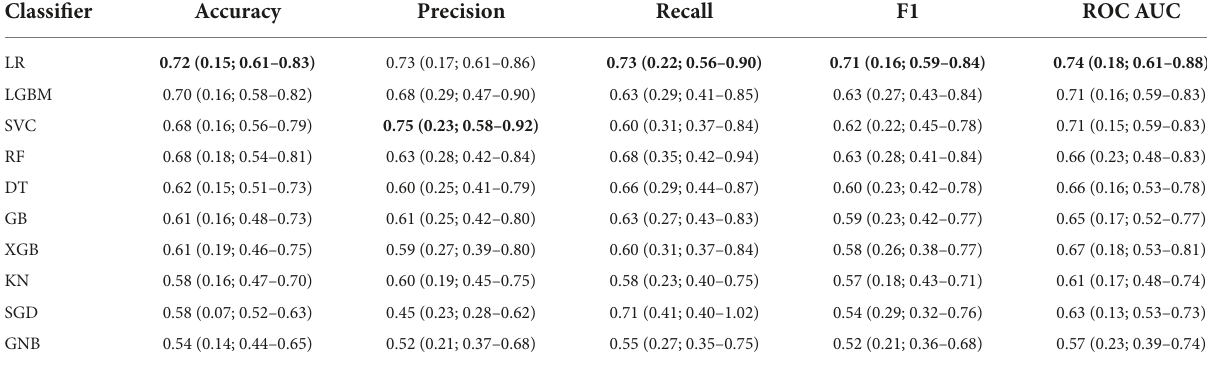
TABLE 5 Results of the models’